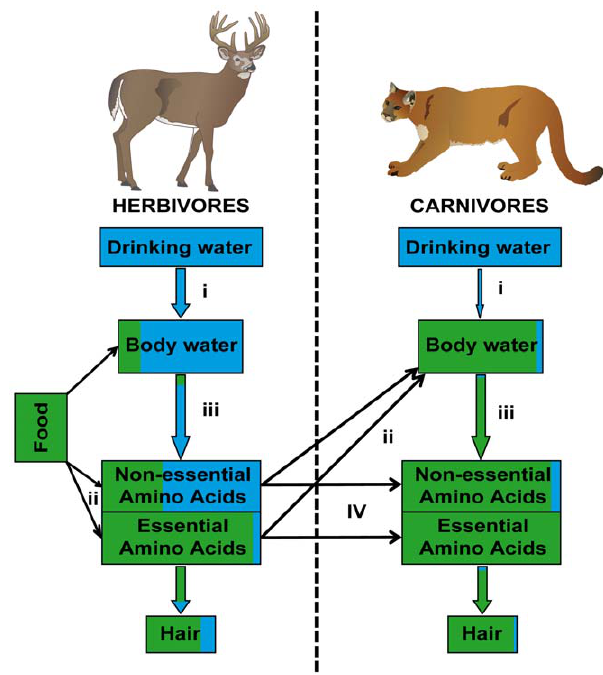
Figure 5. Hydrogen isotope model of herbivores and carni- vores. Model of hydrogen isotope physiology and the contribution of food and water to non-exchangeable hydrogen in the hair of herbivores and carnivores. Letters represent processes where isotope fractionation occurs (see text for detailed discussion). Blue coloring represents water inputs and green food inputs.